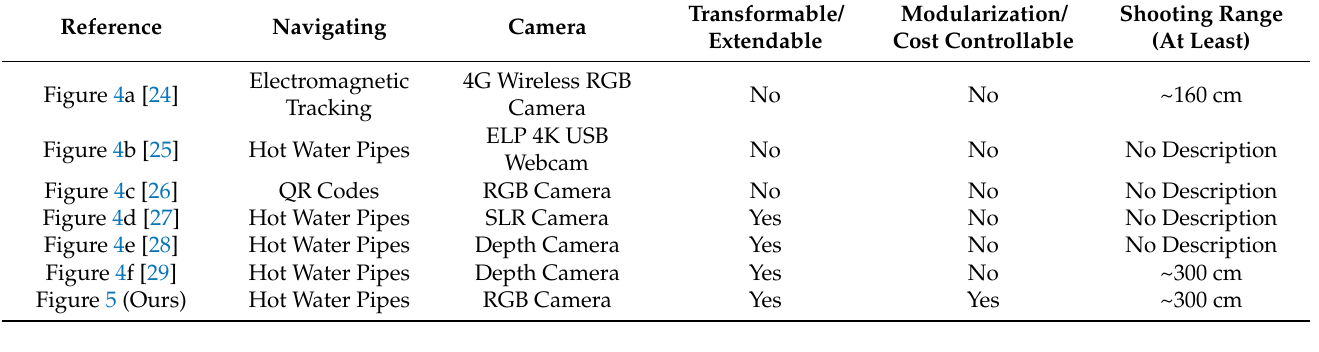
Table 1. A comparison of robots used in recent works with our robot.